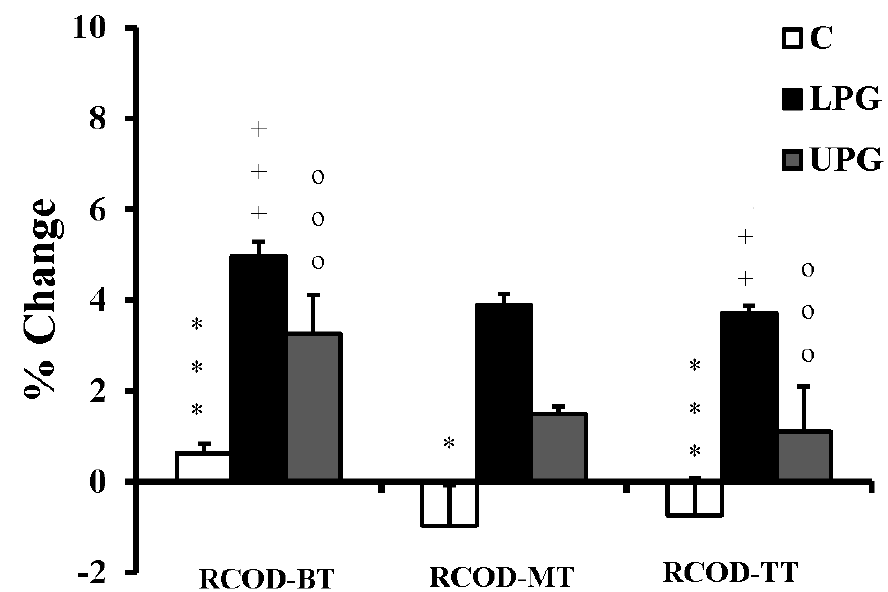
Figure 7. Training associated changes in Repeated Change of Direction (RCOD) test parameters (BT: best time; MT: Mean time; TT: Total time) in loaded plyometric group (LPG), unloaded plyometric group (UPG) and controls (C). * = denotes a significant di ff erence between LPG and C; + = denotes a significant di ff erence between LPG and UPG; o = denotes a significant di ff erence between UPG and C; *: p < 0.05; ***: p < 0.001; ++ : p < 0.01; +++ : p < 0.001; ooo: p < 0.001.